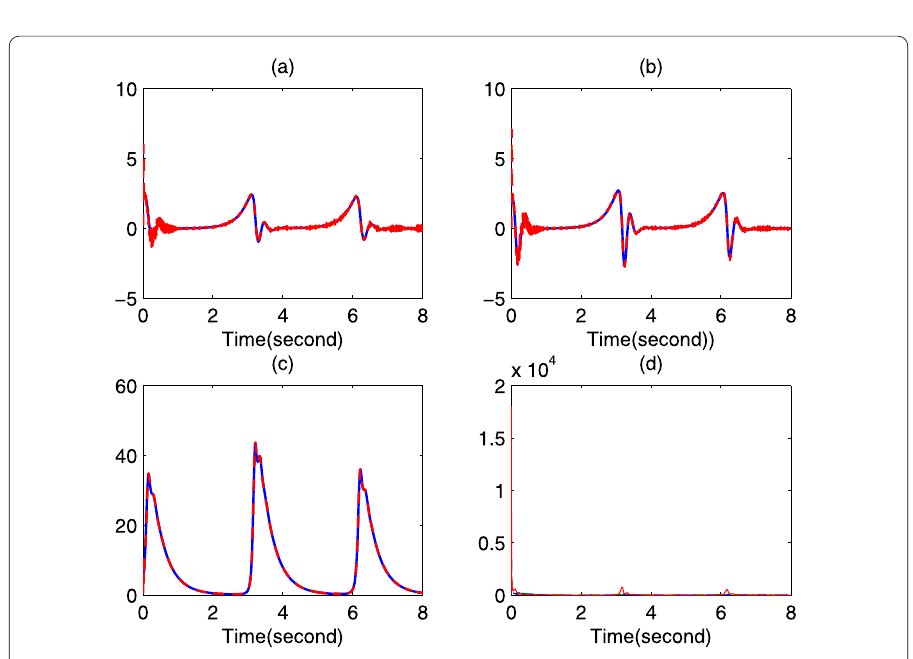
Figure 4 State variables and parameters of the fuzzy logic system. ( a ) x 1 ( t ) (Solid line) and y 1 ( t ) (dotted line), ( b ) x 2 ( t ) (solid line) and y 2 ( t ) (dotted line), ( c ) x 3 ( t ) (solid line) and y 3 ( t ) (dotted line) and (d) (cid:9) θ 1 ( t ) (cid:9) (dotted line), (cid:9) θ 2 ( t ) (cid:9) (chain line) and (cid:9) θ 3 ( t ) (cid:9) (solid